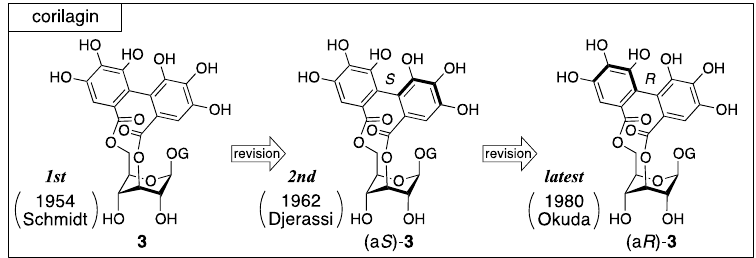
Figure 2. The transition of the structure of corilagin.